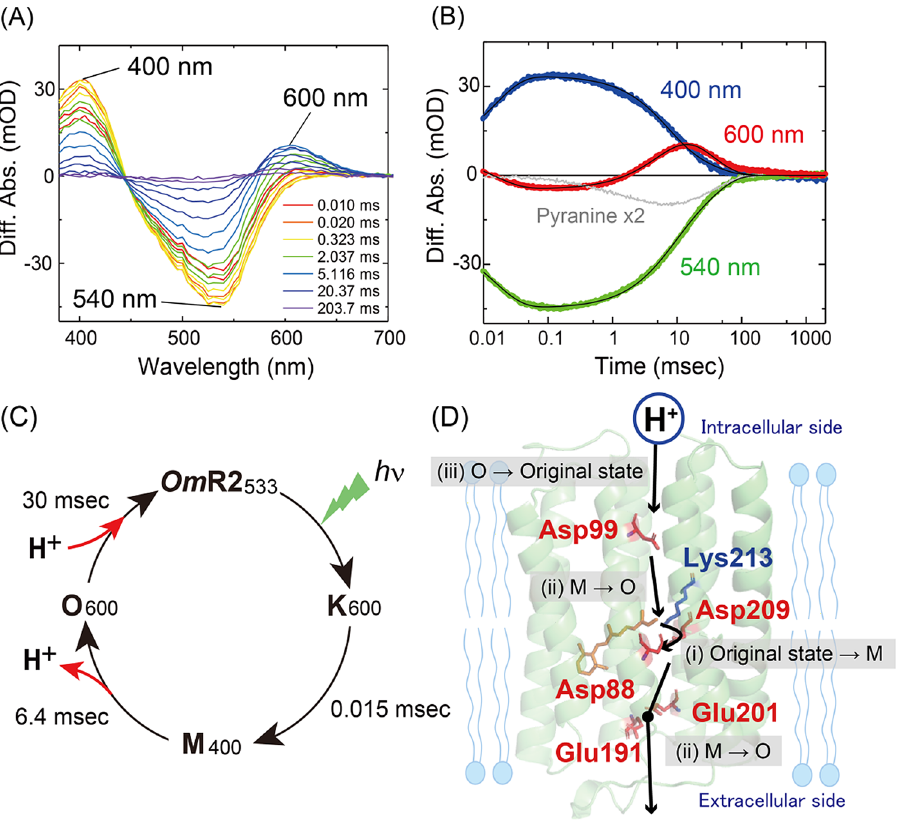
Figure 6. Photocycle and proton transport model of Om R2. ( A ) Flash-induced difference absorption spectra over the spectral range of 380 to 710 nm in Buffer A containing 50 mM Tris–HCl (pH 7.0), 1 M NaCl and 0.05% (w/v) DDM. ( B ) Time courses of absorbance changes at 400, 540 and 600 nm. The black solid lines indicate the fitting curves. The absorption changes of pyranine monitored at 450 nm were enlarged 2 times and are shown as a gray solid line. ( C ) Proposed photocycle model of Om R2 with the timing of the proton release and uptake. ( D ) The proton transport mechanism through some residues in Om R2. The pathway for putative proton